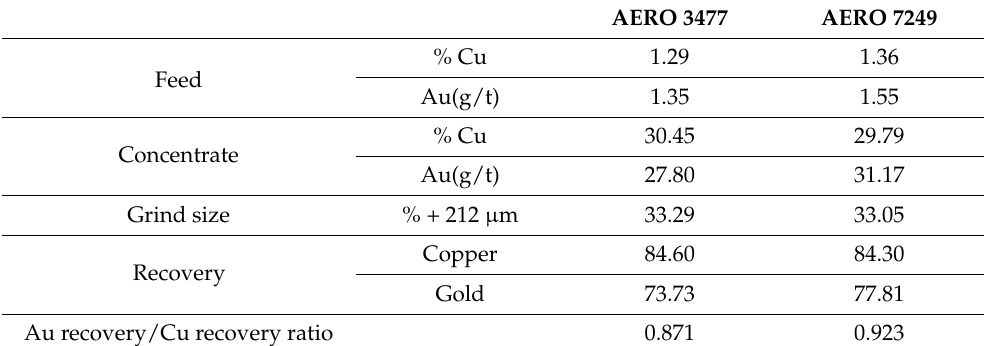
Table 6. The average value of plant data from April 1995 to March 1997 [8].